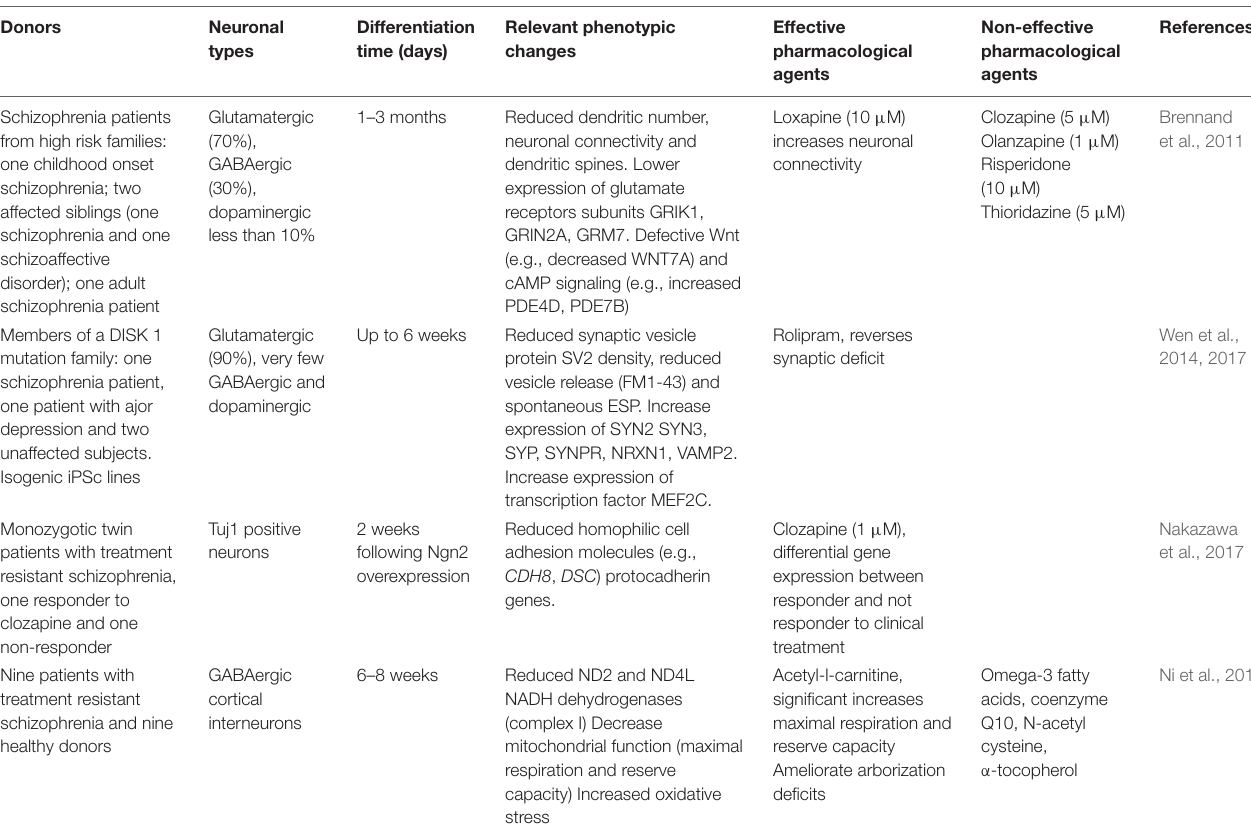
TABLE 1 | Pharmacological studies using iPSC derived neurons from subjects with